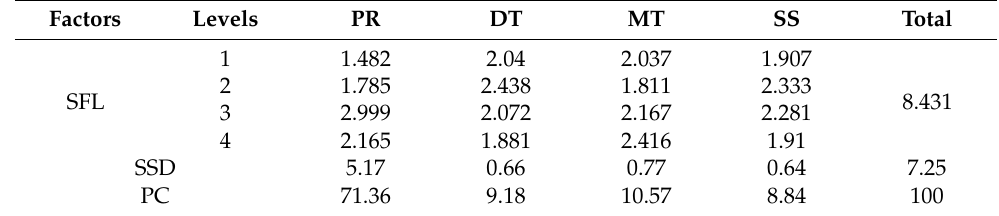
Table 10. The Taguchi-CRITIC-GRA method for combined outputs: Pareto ANOVA. Factors